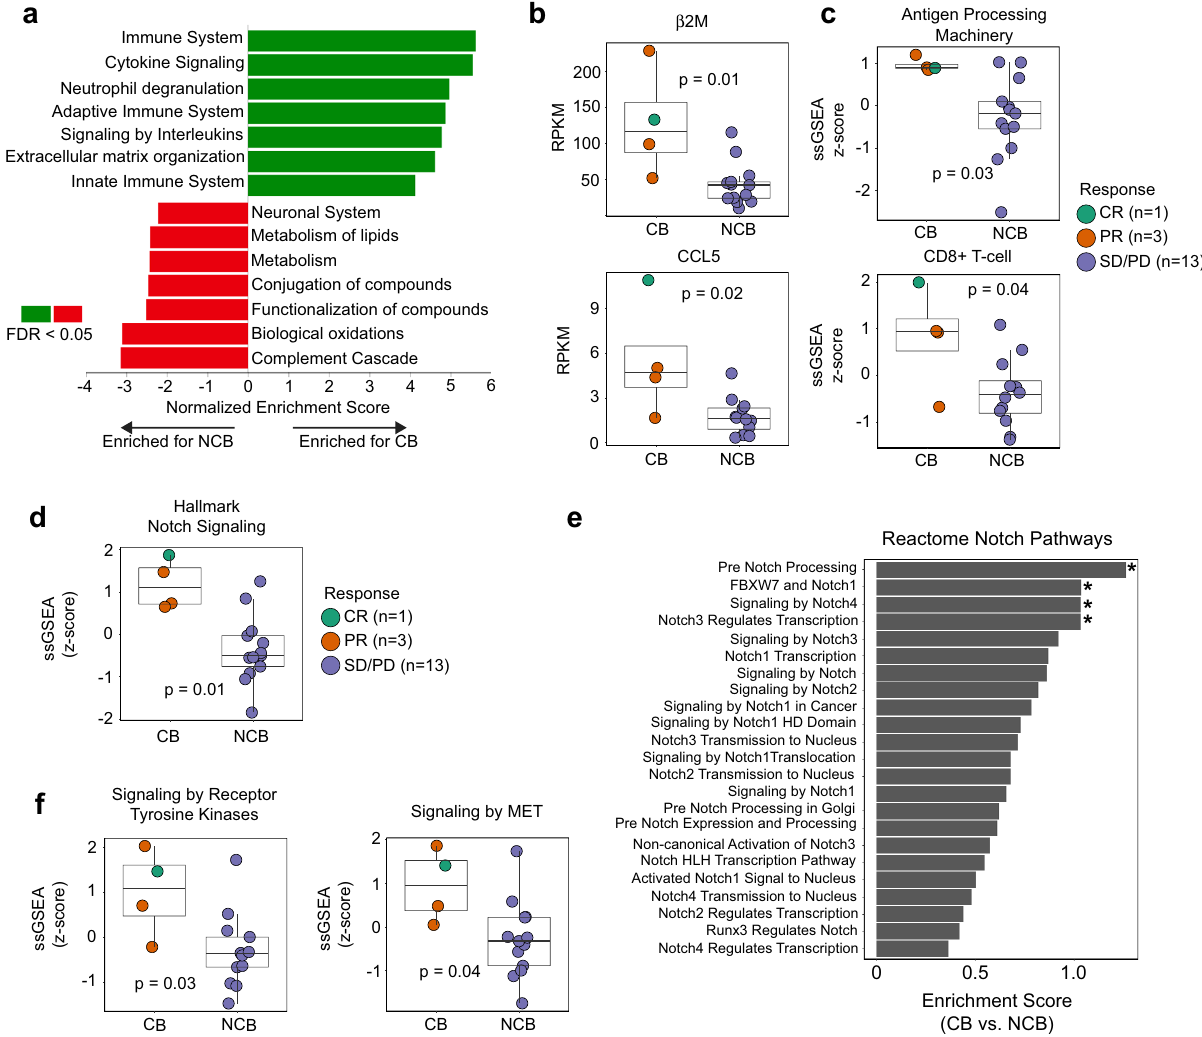
Fig. 2 Notch signaling and immune gene sets are associated with clinical bene fi t to combination immune checkpoint blockade in the relapsed small cell lung cancer discovery cohort. a Bar plot of Reactome gene sets enriched in tumors of patients with clinical bene fi t (CB) and no clinical bene fi t (NCB) to immune checkpoint blockade (ICB) based on differential gene expression analysis. b Expression of immune-related genes, c ssGSEA immune gene set scores, and d ssGSEA Hallmark Notch signaling gene set score in tumors of patients with and without clinical bene fi t following ICB. e Enrichment of Reactome gene sets related to Notch signaling in patients with CB to ICB. Asterisks denote signi fi cantly enriched gene sets (unadjusted p < 0.05) f ssGSEA scores of Reactome gene sets related to receptor tyrosine kinase and MET activation in tumors of patients with and without clinical bene fi t following ICB. Each circle represents a tumor from a given patient; green: complete response; orange: partial response; blue: stable or progressive disease. Statistical signi fi cance was tested with a two-tailed Mann – Whitney U -test. Boxplots represent the median, 25th and 75th percentiles and the vertical bars span